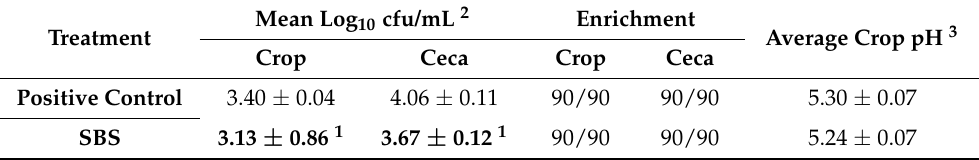
Table 1. Trial 1 colonization and incidence of crop and cecal contents and average crop pH. Treatment